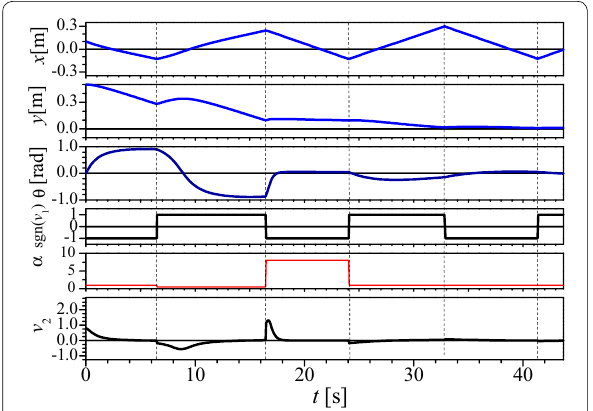
Fig. 8 States and inputs in numerical simulation when α is switched as α 1 0.5 8 = → → →